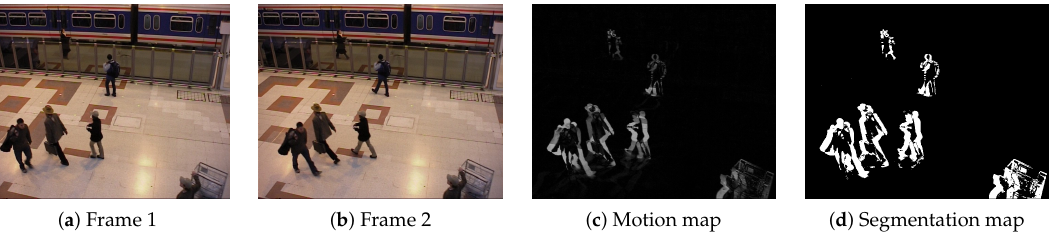
Figure 3. Illustration of the difference between a motion map and a segmentation map. The absolute difference of pixel intensities between frames ( a ) and ( b ) results in the motion map ( c ). Producing the segmentation map ( d ) requires finding an appropriate hard threshold (set to 25 for the example) and prevents knowing how large the difference of pixel intensities